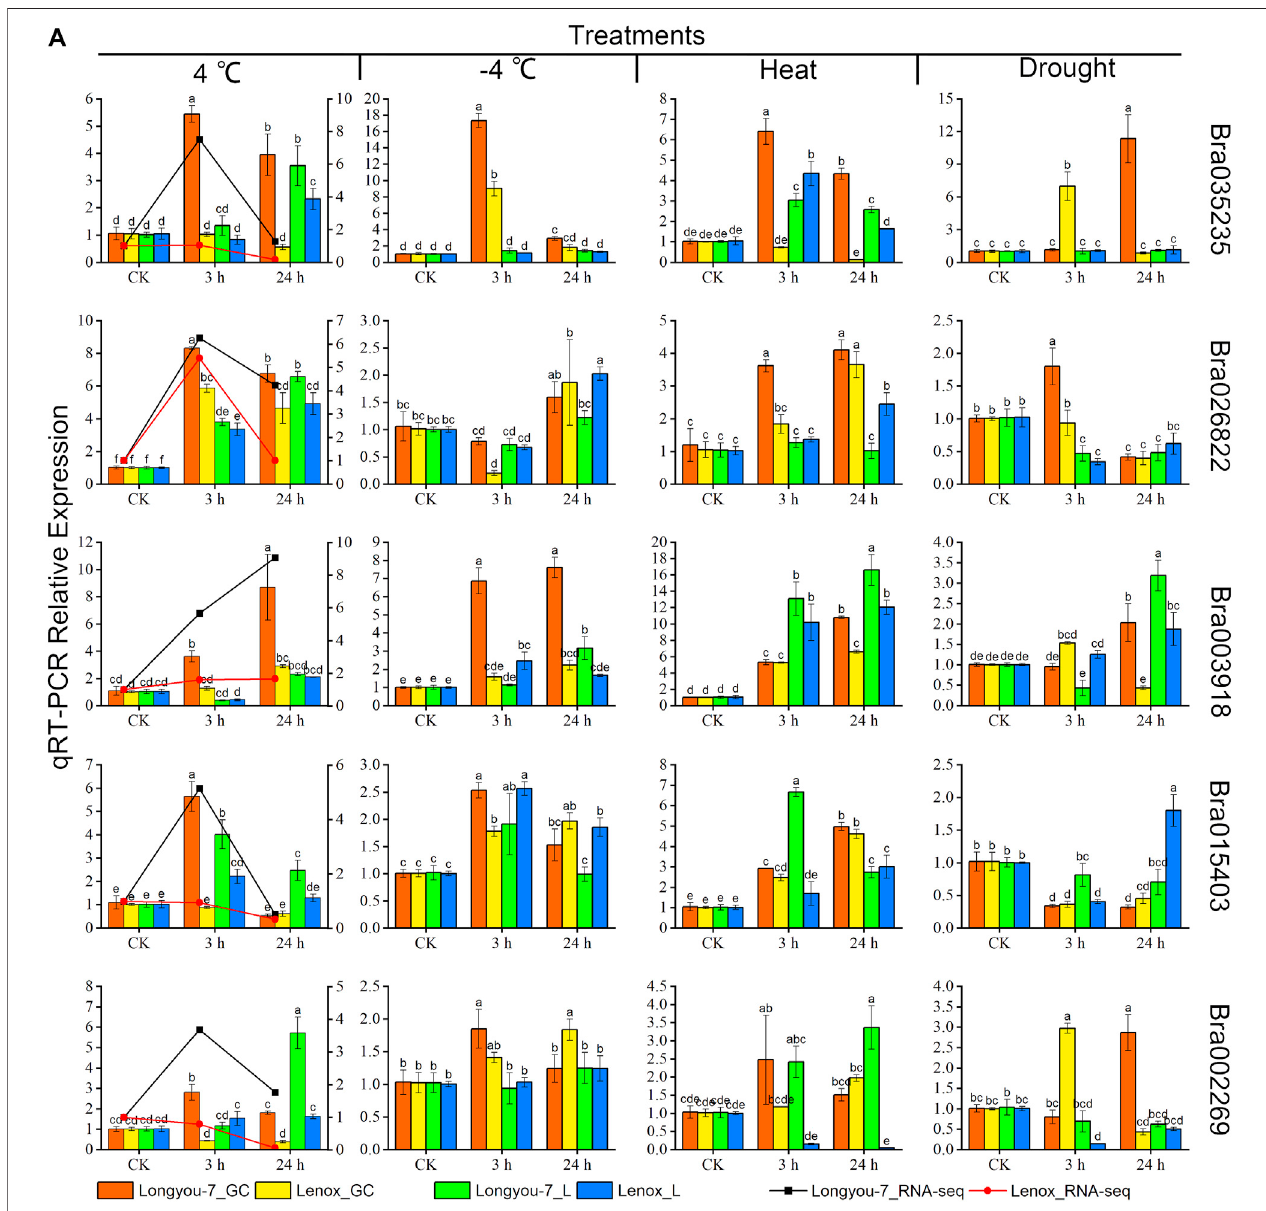
FIGURE 8 | Ten APX genes were analyzed by qRT-PCR expression in growth cones (GC) and leaves (L) of cold-tolerant ( “ Longyou-7 ” ) and weakly cold-resistant varieties( “ Lenox ” )undercold,freezing,drought,andheatstresstreatment (AandB) .Differentcolumnsrepresentfourdifferentabioticstresses,andeachrowshowsthe expression of the same gene under different treatments. The line graph indicates the FPKM values of the growth cones under 4 ° C treatment. Gene expression was normalized to the expression level of normal growth at room temperature and assigned a value of 1. Data represent the mean ± standard error for three biological experiments, with standard errors shown as bar charts above the columns, while lowercase letters indicate signi fi cance at p <